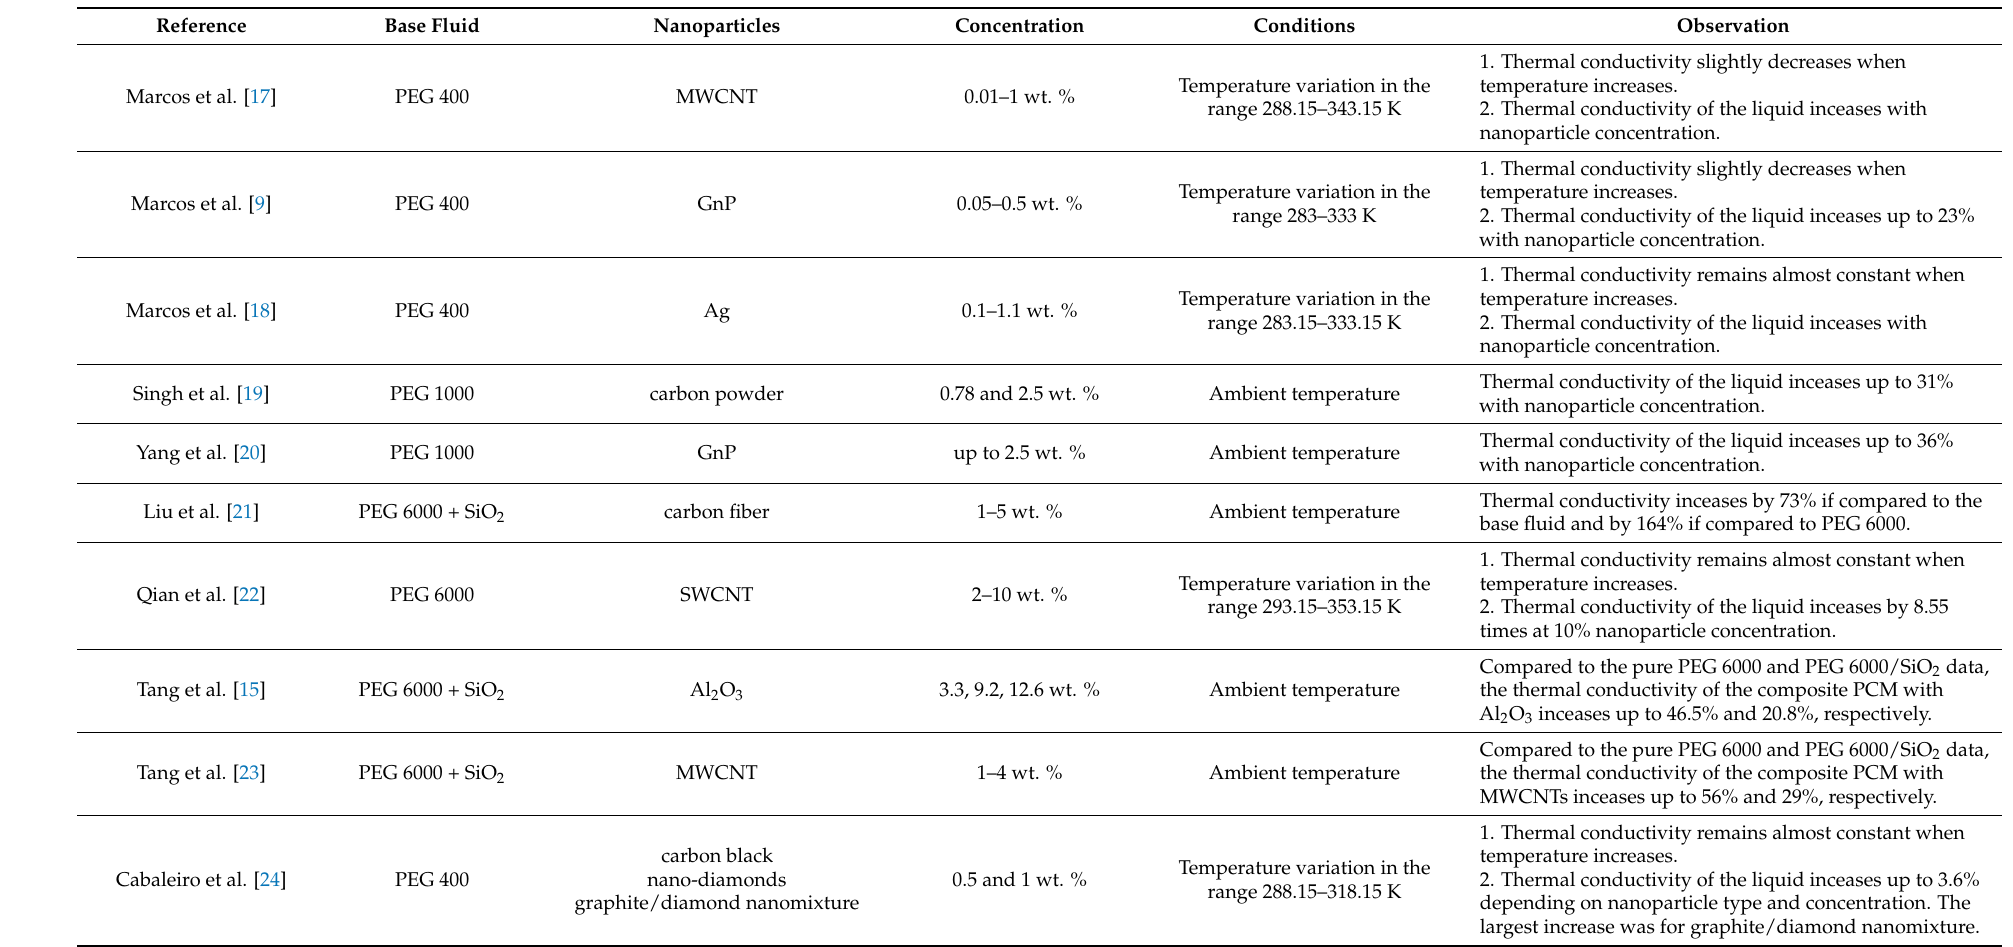
Table 3. Results for thermal